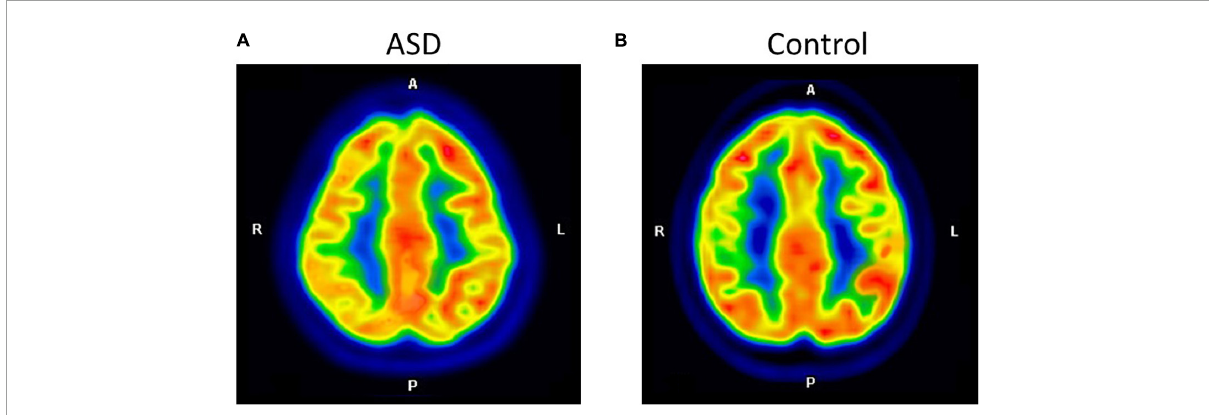
FIGURE1 The axial images of the F-18 FDG PET/CT scan demonstrated relatively decreased FDG uptake at the right parietal inferior compared to the left parietal inferior in ASD (A) . The control participant shows normal FDG uptake in the same region (B) .